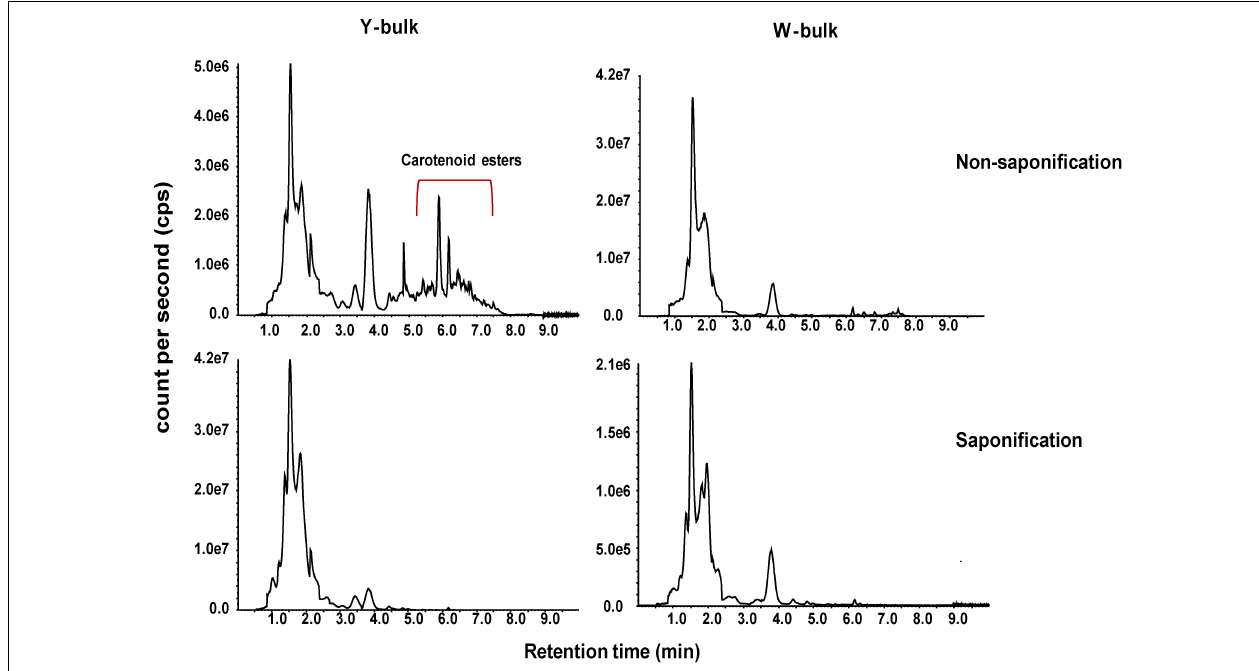
FIGURE 2 | Total ion chromatograms of carotenoids in yellow and white petals. Carotenoids extracts from mature yellow (left column) and white (right column) petals were subjected to LC-APCI-MS/MS analysis under non-saponification (up row) and saponification (down row) treatments.